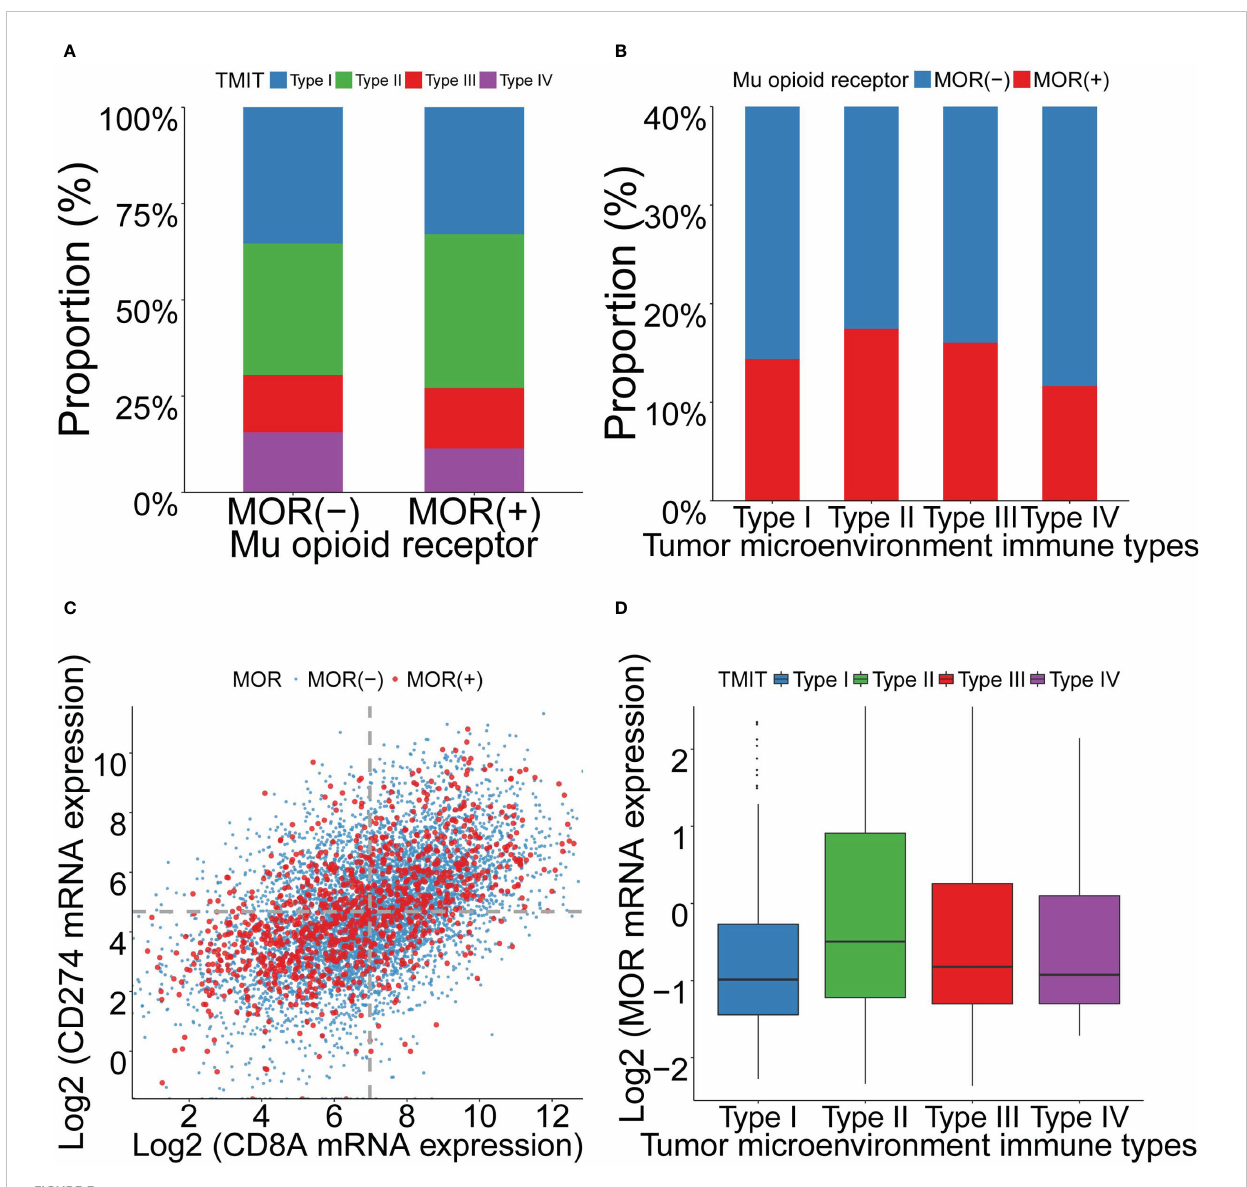
FIGURE 3 Association between MOR mRNA expression and TMITs, as well as correlation between PD-L1 and CD8A expression across 18 cancer types. Footnotes: (A) Distribution of TMITs according to MOR expression. (B) Distribution of MOR expression according to TMITs. (C) Correlation between mRNA expression level of PD-L1 and CD8A. (D) The mRNA expression level of MOR according to